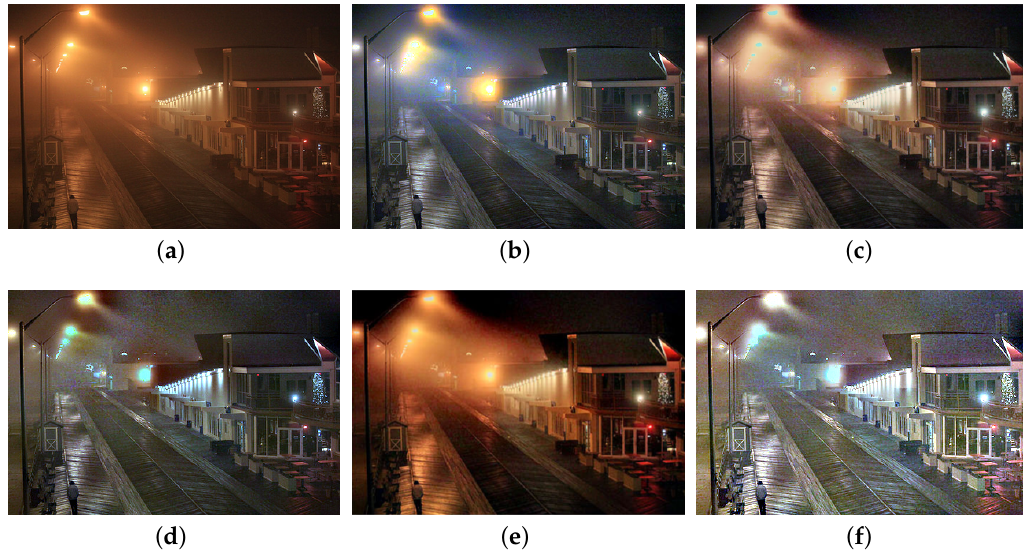
Figure 10. Comparisons with other nighttime dehazing methods on test image Street . ( a ): the nighttime hazy image, ( b ): MRP [11] result, ( c ): HDF [41] result, ( d ): GMLC [13] result, ( e ): PAB [9] result, ( f ): SIDE